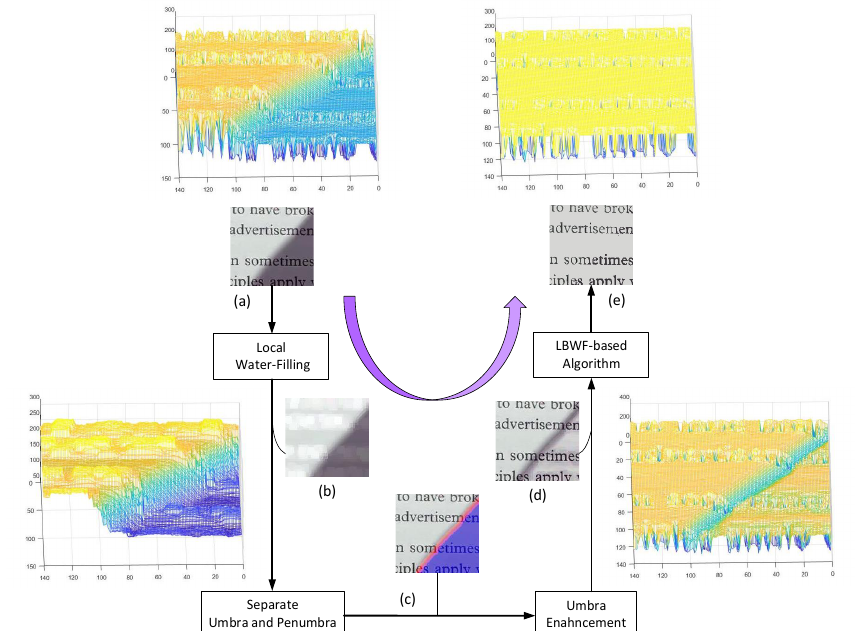
Figure 2. The flowchart of optical shadows removal. ( a ) input image, ( b ) shading map, ( c ) the red represents umbra and the purple represents penumbra, ( d ) the image after umbra enhancement, ( e ) the output image without shadows.